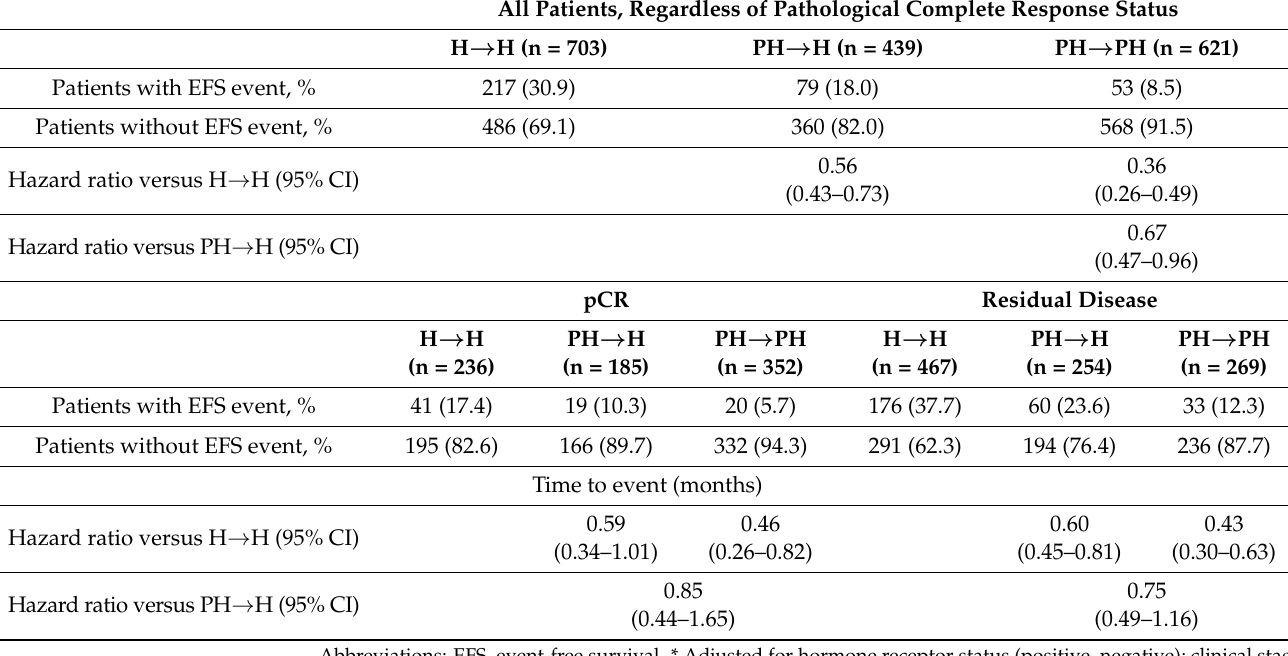
Table 3. Treatment effect by pathological complete response and treatment modality using inverse probability of treatment weighting analysis *.